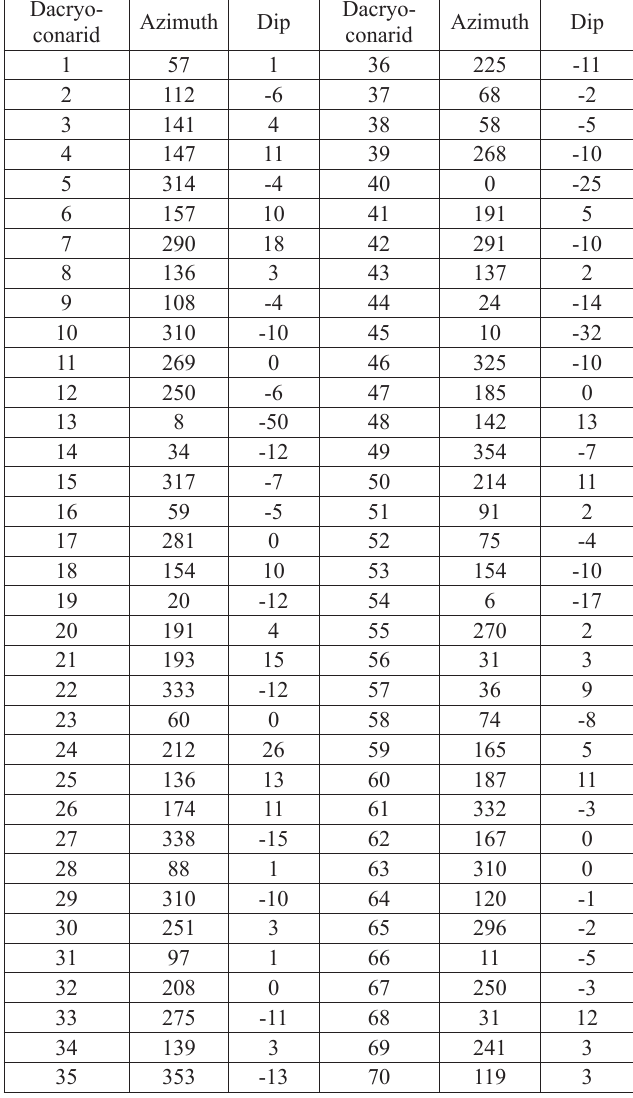
Table 1. Measured orientations of the dacryoconarids.